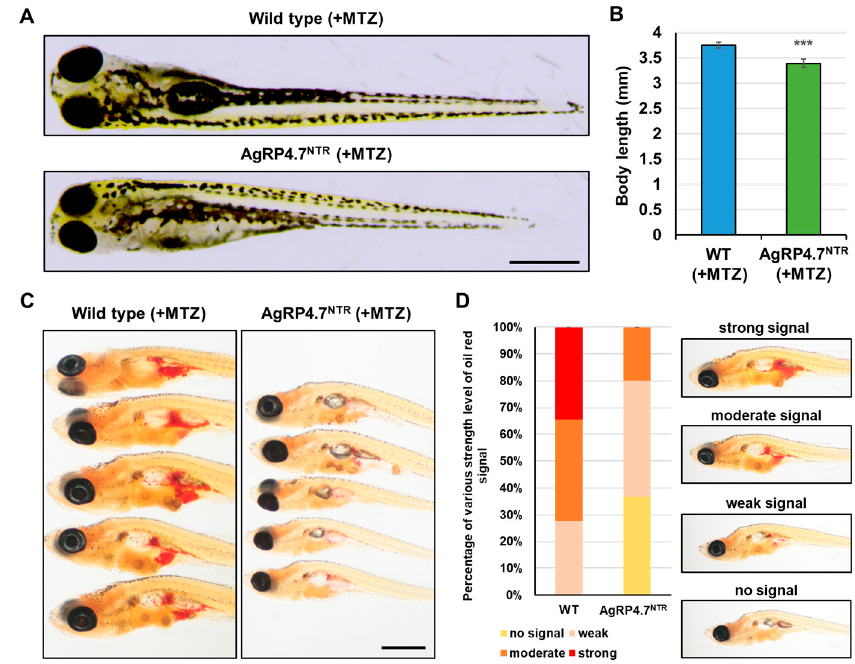
Figure 6. AgRP neuron ablation results in the inhibition of somatic growth and adipocyte formation. ( A ) Lateral view of MTZ-treated WT and AgRP4.7 NTR larvae at 8 dpf. Scale bar: 500 µm. ( B ) Statistics of body length measurement between MTZ-treated WT and AgRP4.7 NTR larvae at 8 dpf. All values are reported as mean ± SEM, n = 30. *** p < 0.001. ( C ) Lipid droplet accumulation was observed via whole-body Oil Red O staining of MTZ-treated WT and AgRP4.7 NTR larvae at 21 dpf. Scale bar: 1 mm. ( D ) Left: Distribution of lipid droplets in MTZ-treated WT and AgRP4.7 NTR larvae at 21 dpf, n = 30. Right: Intensity grading diagram.